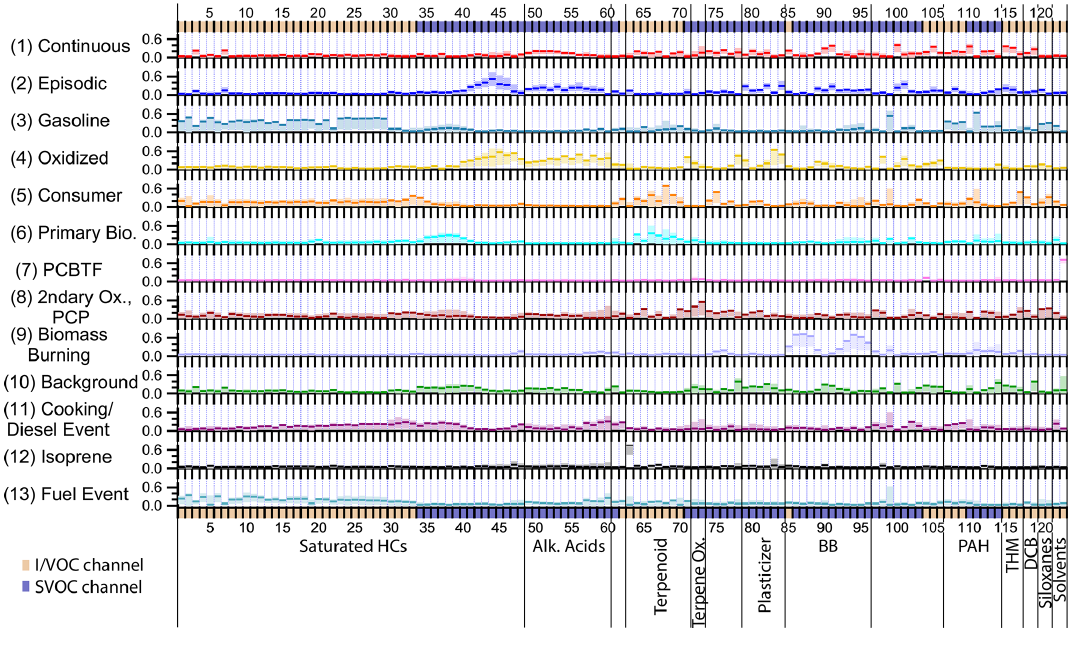
Figure 2. The 13-factor solution factor profiles. Compounds are ordered as in Table 1 using the indices assigned. Unlabeled groups are labeled “other” in Table 1. The shaded areas behind each profile represent 5th and 95th percentile contributions based on bootstrapping analysis, as described in Sect. S2.3.